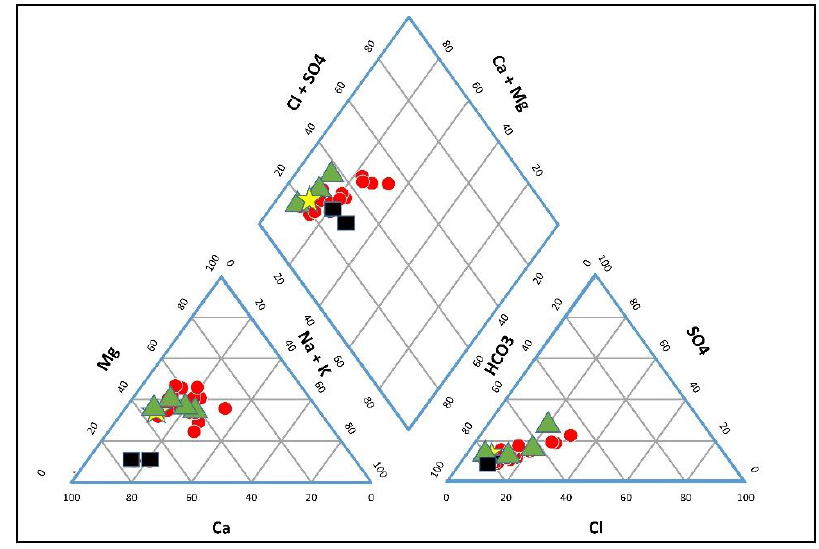
Figure 5. A piper trilinear diagram showing the major ionic composition of boreholes, shallow wells, springs, and tap water in the study